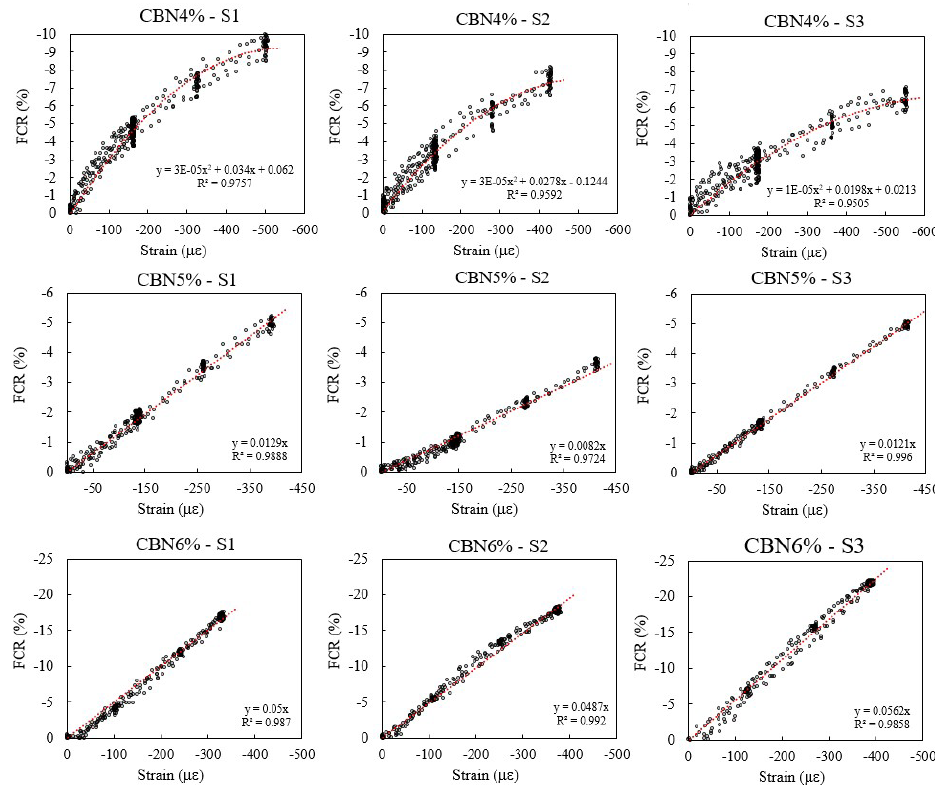
Figure 11. Relationship between FCR and strain of self-sensing